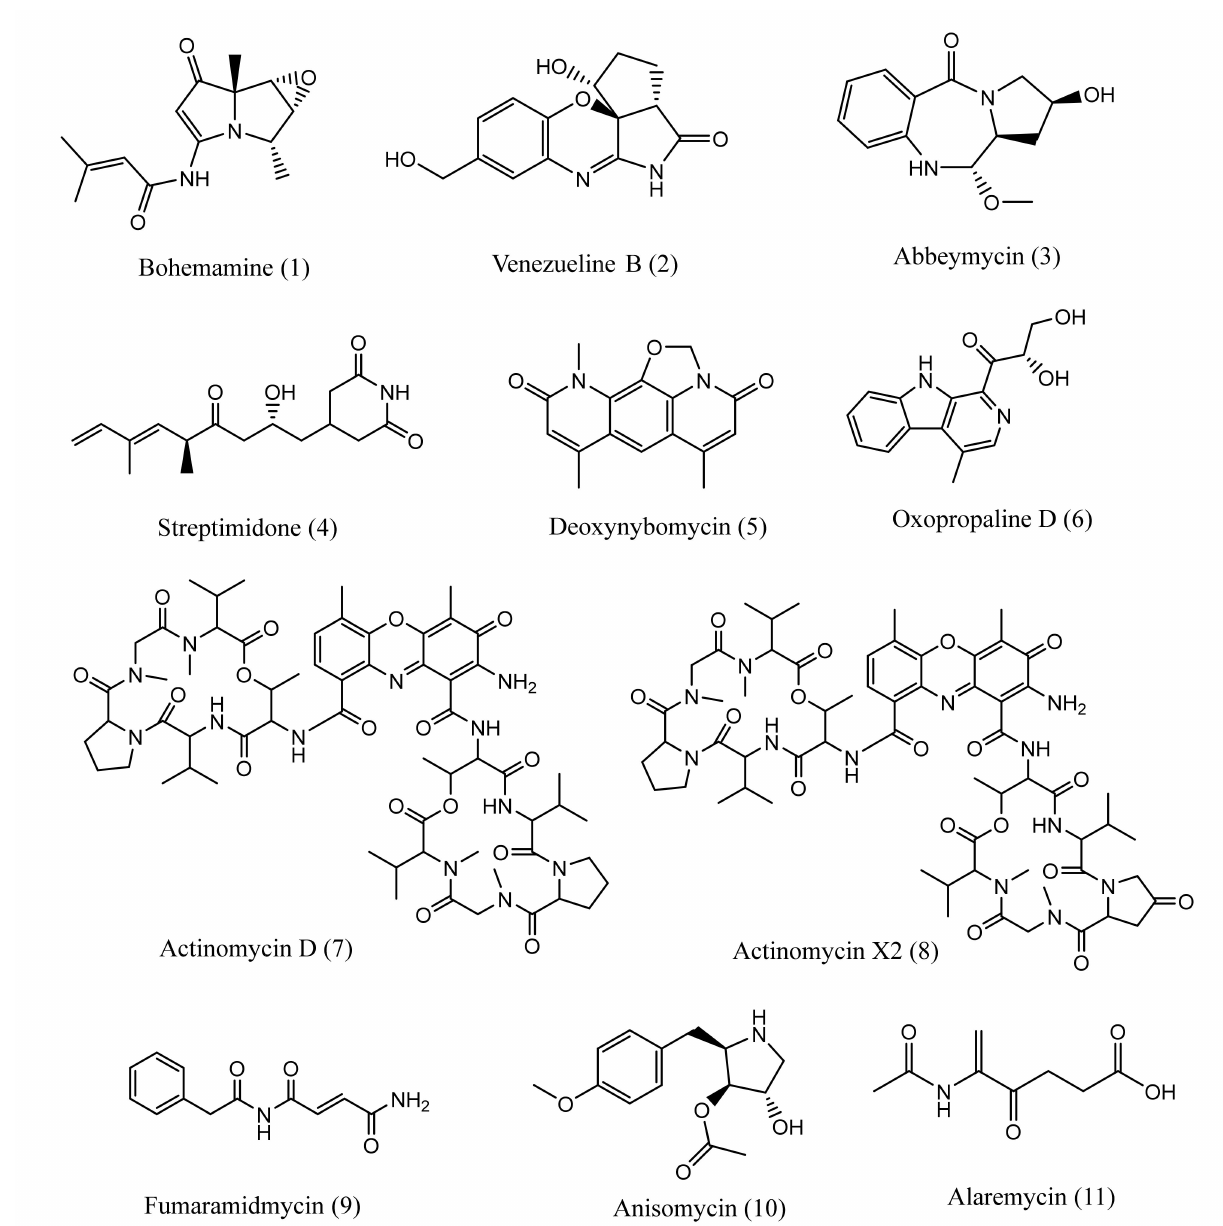
Figure 5. Chemical structures of some annotated metabolites from BN6 (1–6) and BN14